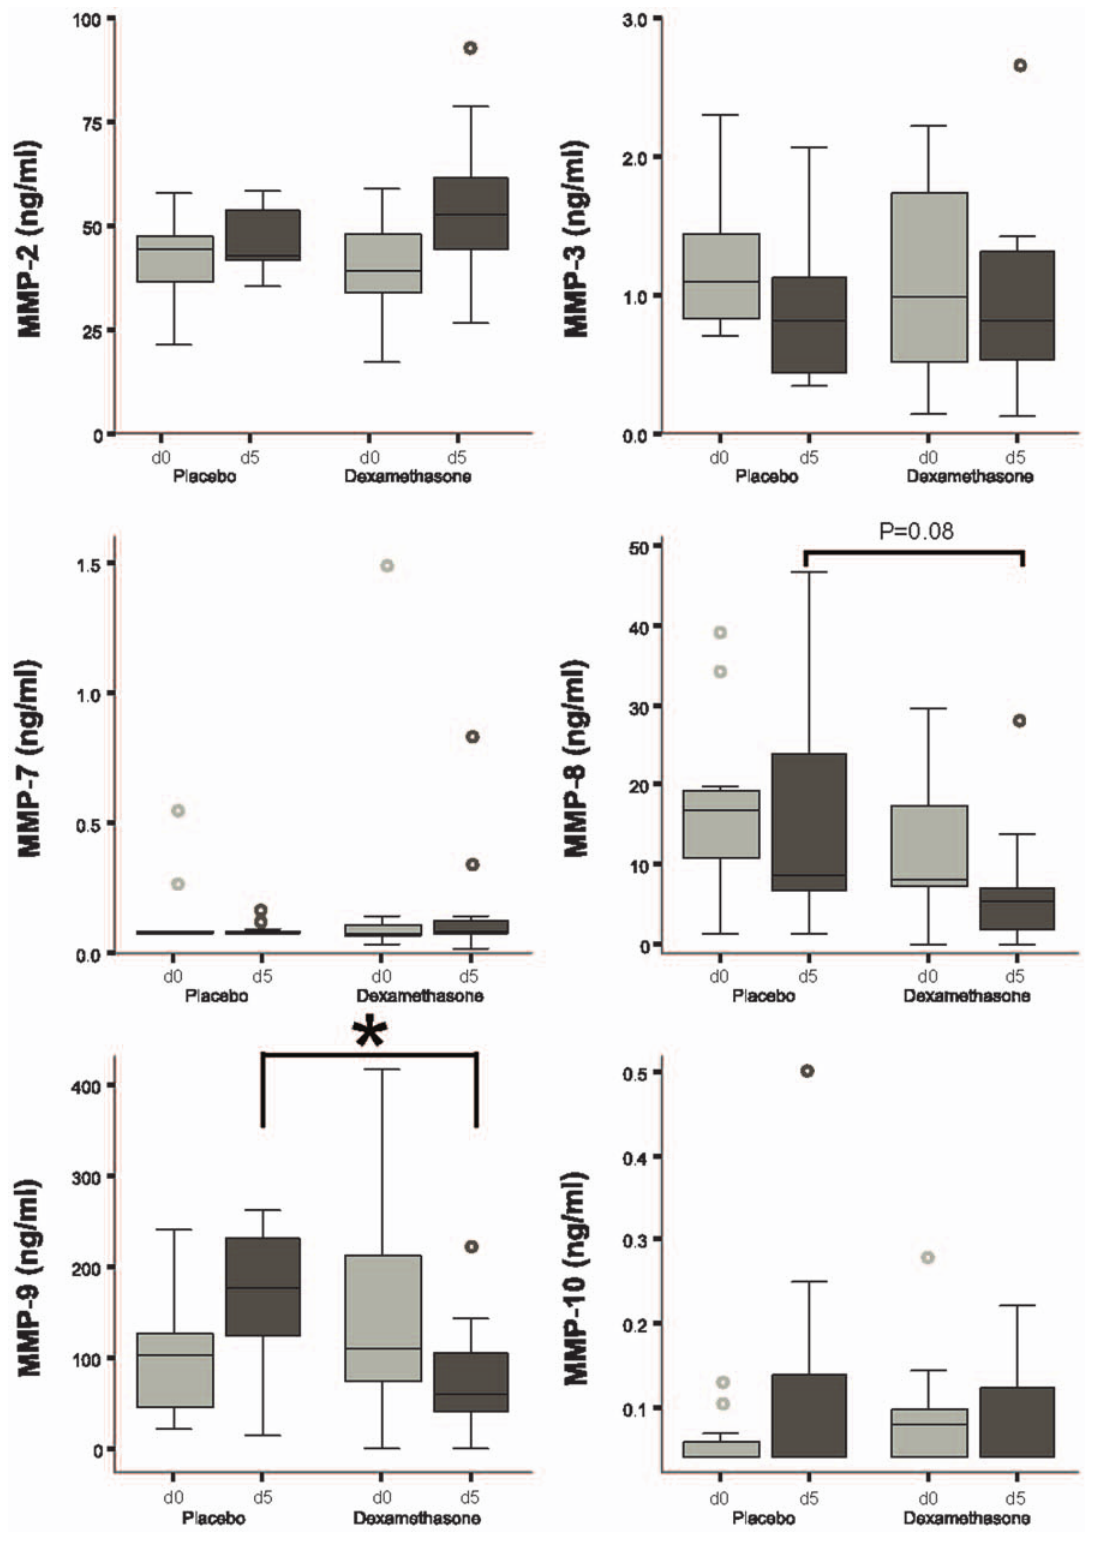
Figure 1. Dexamethasone reduces CSF MMP-9 concentrations in early follow up samples. Paired CSF samples from patients with tuberculous meningitis were taken pre-treatment and at early follow up, a median 5 days (range 3–8) into anti-tuberculosis therapy, and analyzed for MMP-1, -2, -3, -7, -8, -9 & -10 concentration by ELISA (MMP-6, -7 & -8 do not exist). Patients who received placebo (light grey bars, n=11) had significantly higher MMP-9 concentrations in their early follow-up CSF samples than those whoreceived dexamethasone(dark grey bars, n=11). *, p=0.01.Theblack line represents the median value and the box the interquartile range. Whiskers represent 1.5 times the interquartile range away from the box.